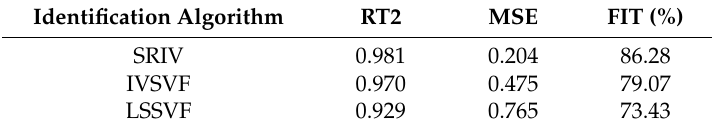
Figure 18. Step response of EPS for sampling rates of 800 Hz and 1 kHz. Table 10. Evaluation parameters using three different identification parameters.